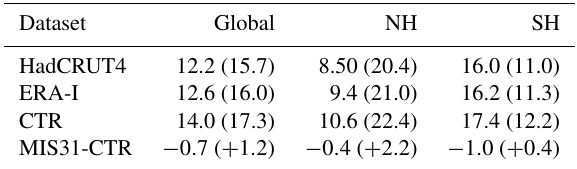
Table 1. Averaged surface temperatures ( ◦ C) for the CTR, ERA-I, and HadCRUT4 (1980–2010). Differences between MIS31 and the CTR runs are also shown. Values in brackets are for JJA (June, July, and August). Otherwise values are computed for DJF (December, January, and